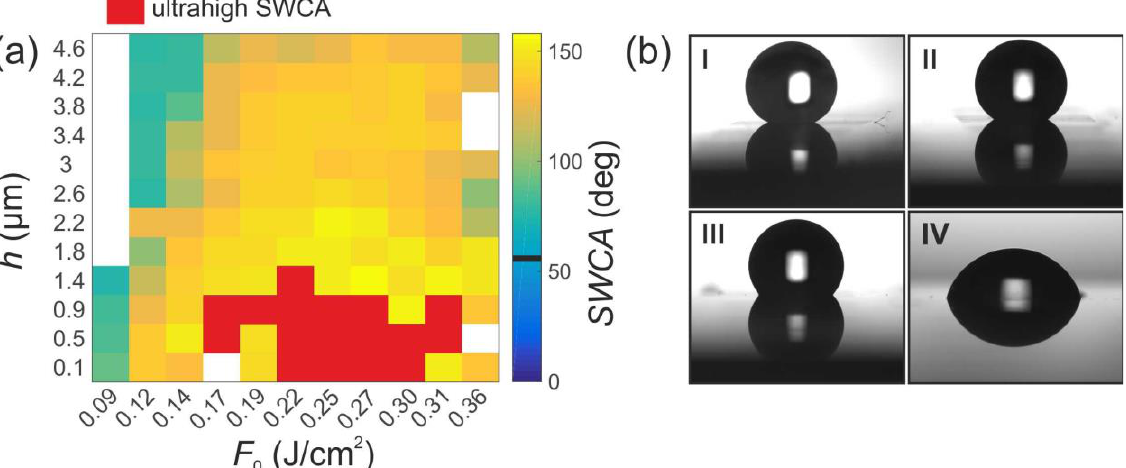
Figure 2. ( a ) Dependence of the static water contact angle (SWCA) of the samples prepared using beam array area hatching on the laser fluence F 0 and hatch distance h; black line on the color bar indicates SWCA value of an untextured surface (63.3 ± 1.9°). ( b ) Water drops on the surfaces, struc- indicates SWCA value of an untextured surface (63.3 ± 1.9 ◦ ). ( b ) Water drops on the surfaces, struc- tured using various parameters: ( I ) — h = 1.4 µm, F 0 = 0.27 J/cm 2 ; ( II ) — h = 1.8 µm, F 0 = 0.25 J/cm 2 ; tured using various parameters: ( I )—h = 1.4 µ m, F 0 = 0.27 J/cm 2 ; ( II )—h = 1.8 µ m, F 0 = 0.25 J/cm 2 ; ( III ) — h = 4.2 µm, F 0 = 0.25 J/cm 2 ; and ( IV ) — h = 1.4 µm, F 0 = 0.09 J/cm 2 . ( III )—h = 4.2 µ m, F 0 = 0.25 J/cm 2 ; and ( IV )—h = 1.4 µ m, F 0 = 0.09 J/cm 2